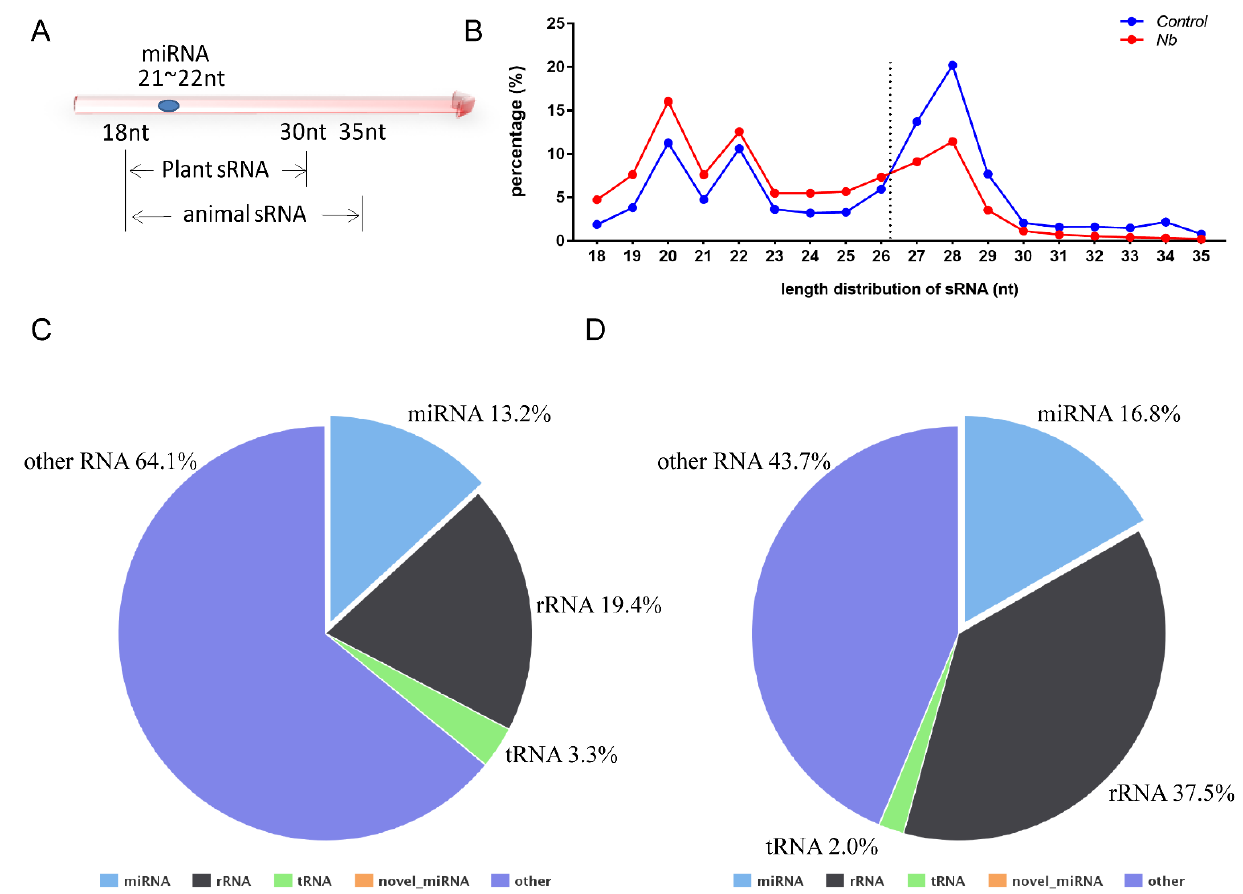
Figure 2. RNA sequence data analysis of BmE cells infected by N. bombycis and uninfected cells ( A ) Length range of sRNA in animals and plants. ( B ) Percentage of the sRNA mapped to the reference sequence of two groups. ( C , D ) The proportions of known miRNAs, rRNAs, tRNAs and other RNAs in mapped sRNA of the control group and the infected group.